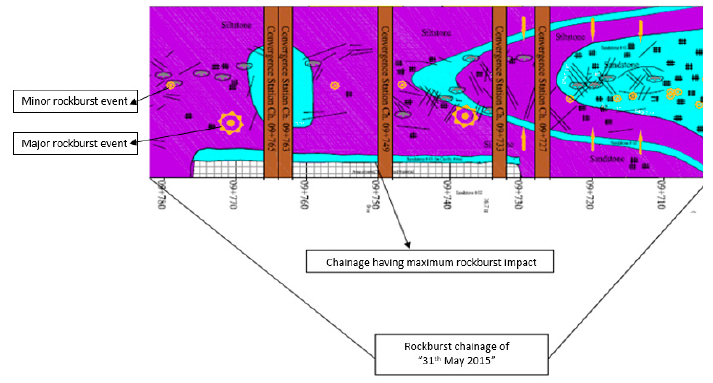
Figure 4. Geological map of the right tunnel, showing the abnormal geology.